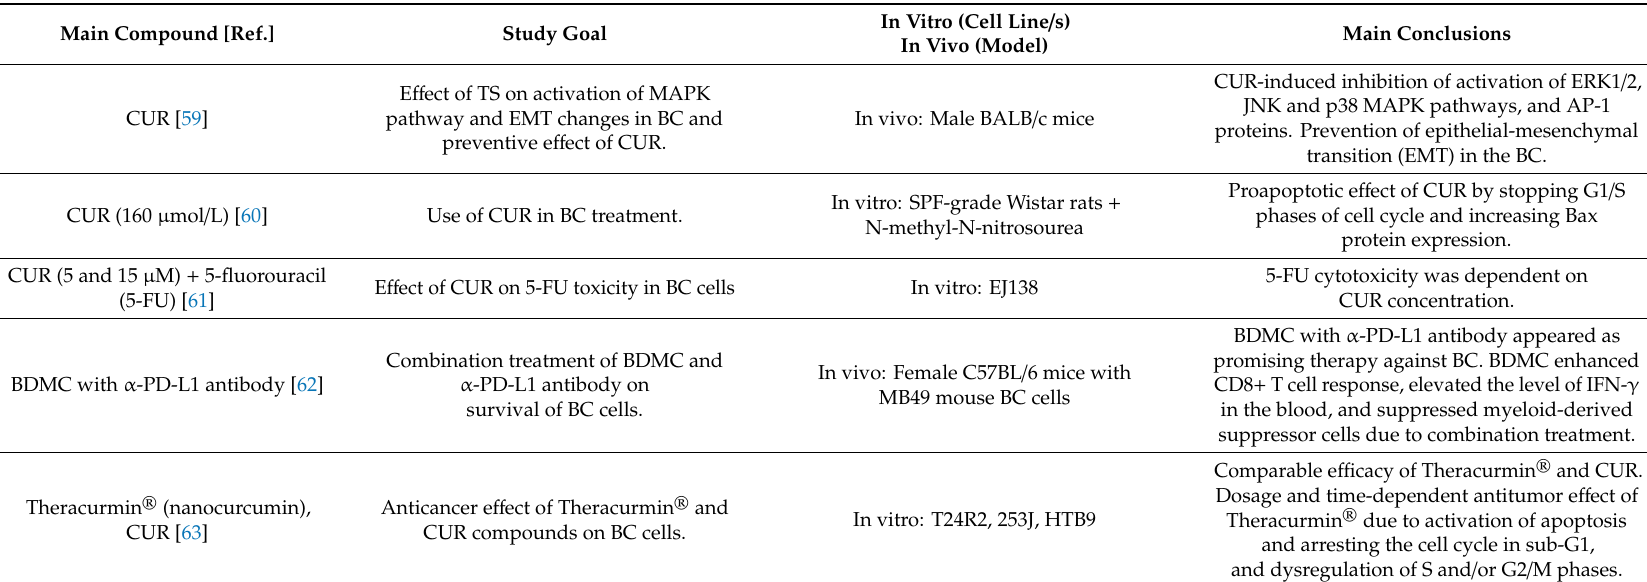
Table 2. Profiles of publications concerning epigallocatechin gallate (EGCG) selected for the review. Main Compound